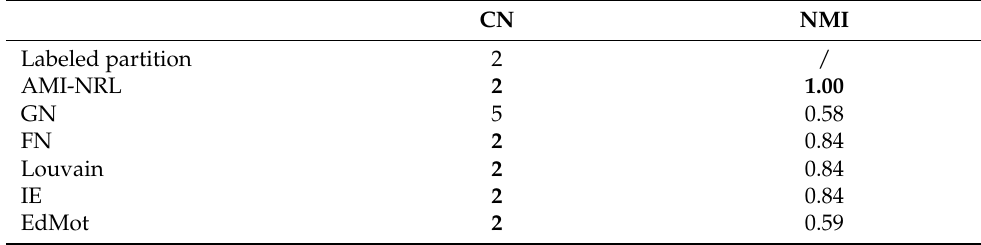
Table 3. Results of AMI-NRL and the other community detection algorithms on Dolphins. The bold numbers emphasize the best experimental results compared with the labeled